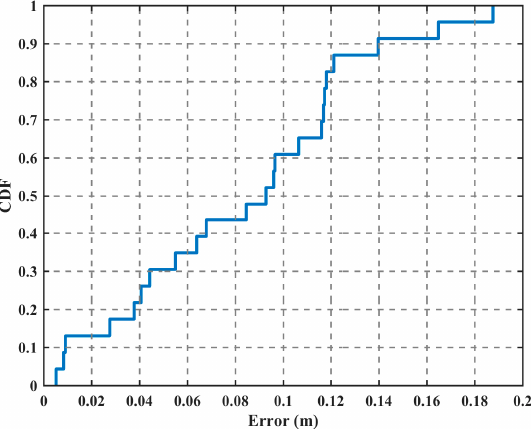
Figure 10. CDF for the handheld SLAM device